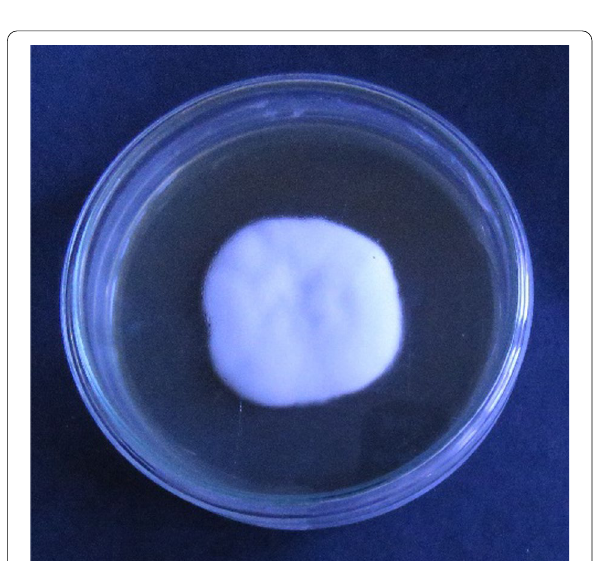
Fig. 6 Lecanicillium longisporum isolated from soil